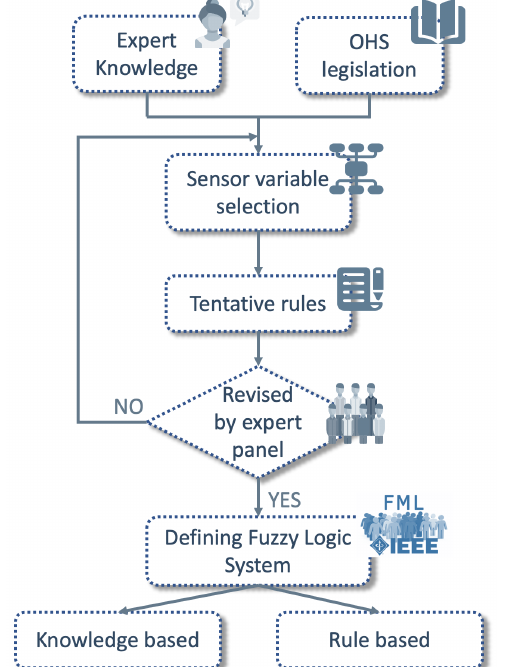
Figure 2. Methodology to represent the expert knowledge from a panel of